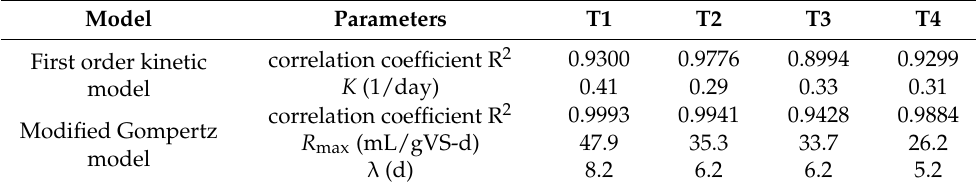
Figure 3. Analysis of kinetic model, which included ( a ) linear regression fits for estimation of hydrolysis constants ( K ) and ( b ) modified Gompertz equation from the batch assay data for AD of F-CS and D-CS. Table 4. Parameters of the first-order kinetic and modified Gompertz model.